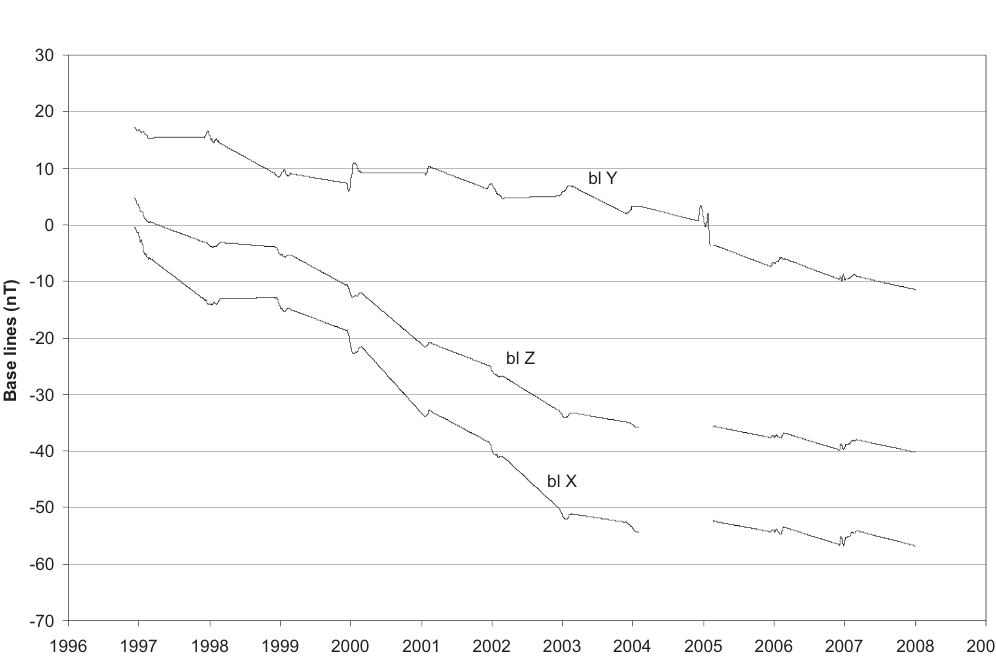
Fig. 1. X, Y and Z baselines adopted for LIV during its complete period of operation. Periods with non-linear baselines centred at the beginning of each year (of around 3 month span on average) correspond to summer Antarctic surveys, i.e. periods with absolute control. The observed differences from the absolute measurements that give rise to the adopted baselines are not plotted because they would be indistinguishable at this temporal scale; they can be found in the corresponding bulletins (Marsal et al. , 2007a and references therein). The base- lines adopted for the periods between surveys are linear functions with the necessary slopes to pass from the adopted differences at the end of one survey to those of the beginning of the next one. The period without base- lines for X and Z corresponds to a failure in the vector magnetometer, from October 2004 to February 2005, that prevented them from being obtained for the whole period between